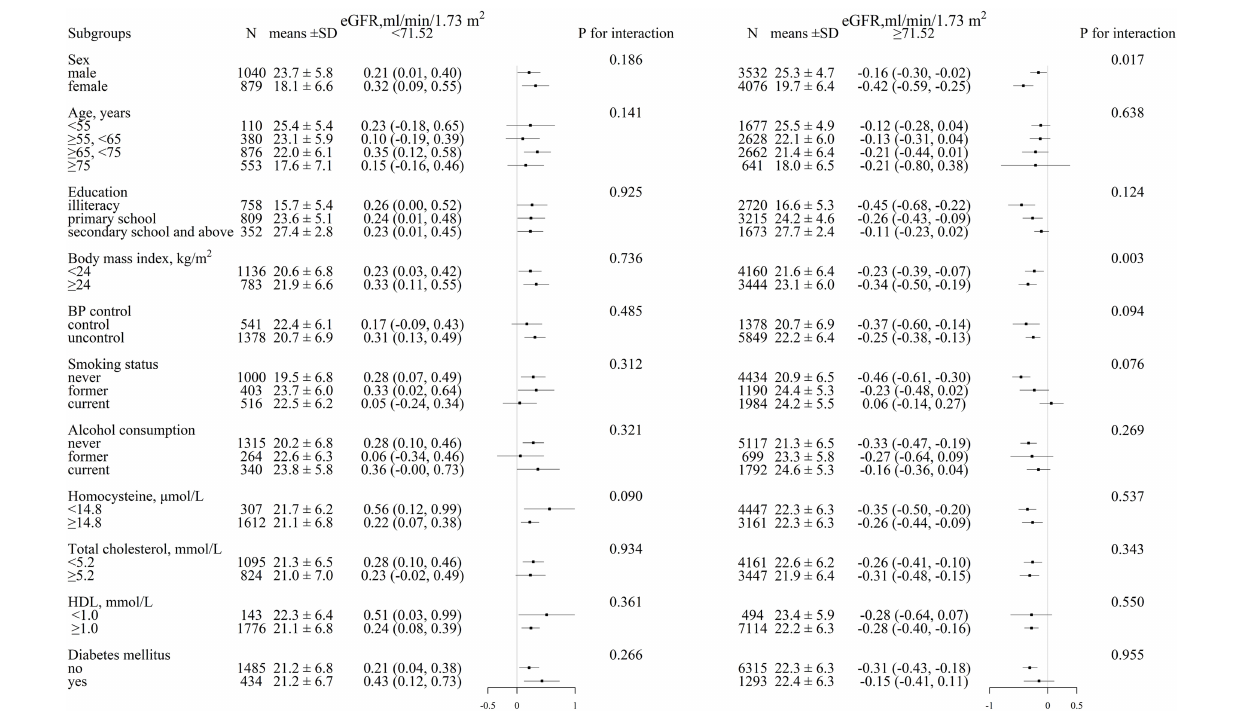
impairment than those with eGFR of 65–75 ml/min/1.73 m 2